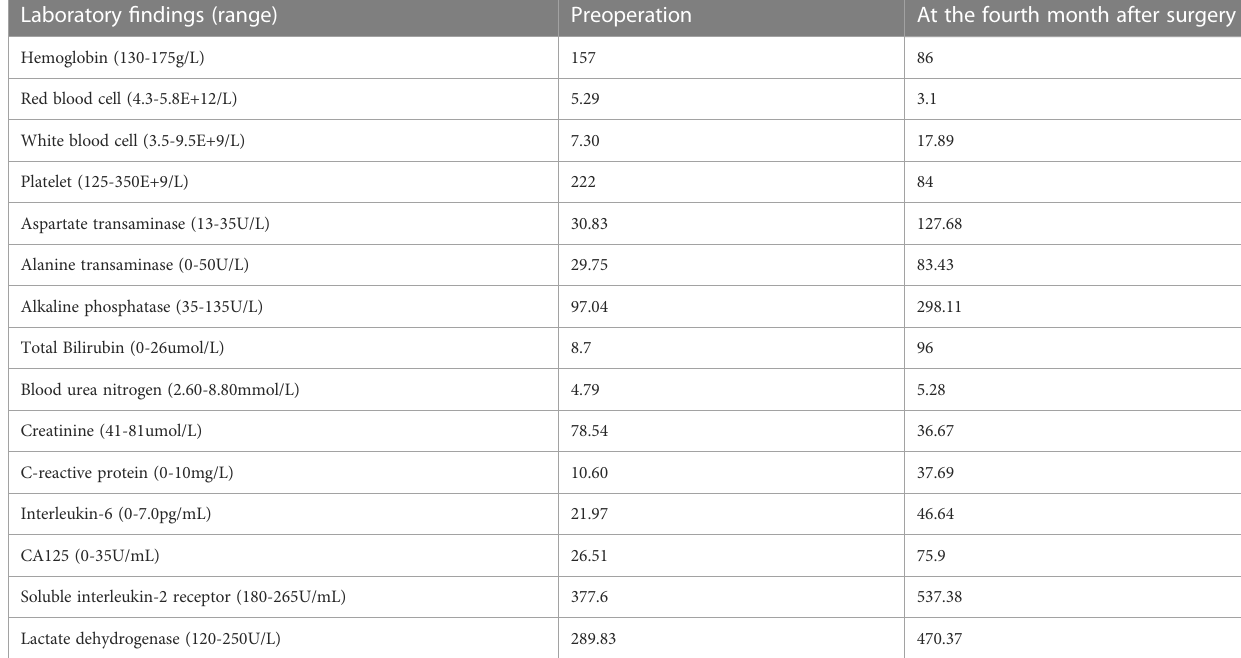
TABLE 1 The laboratory fi ndings of the